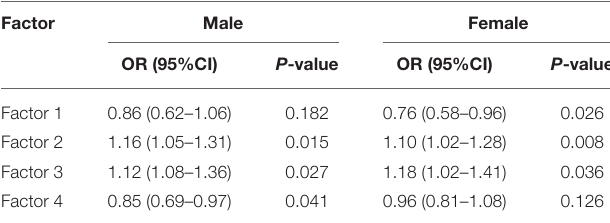
TABLE 5 | Different gender dietary patterns are associated with the risk of depression.